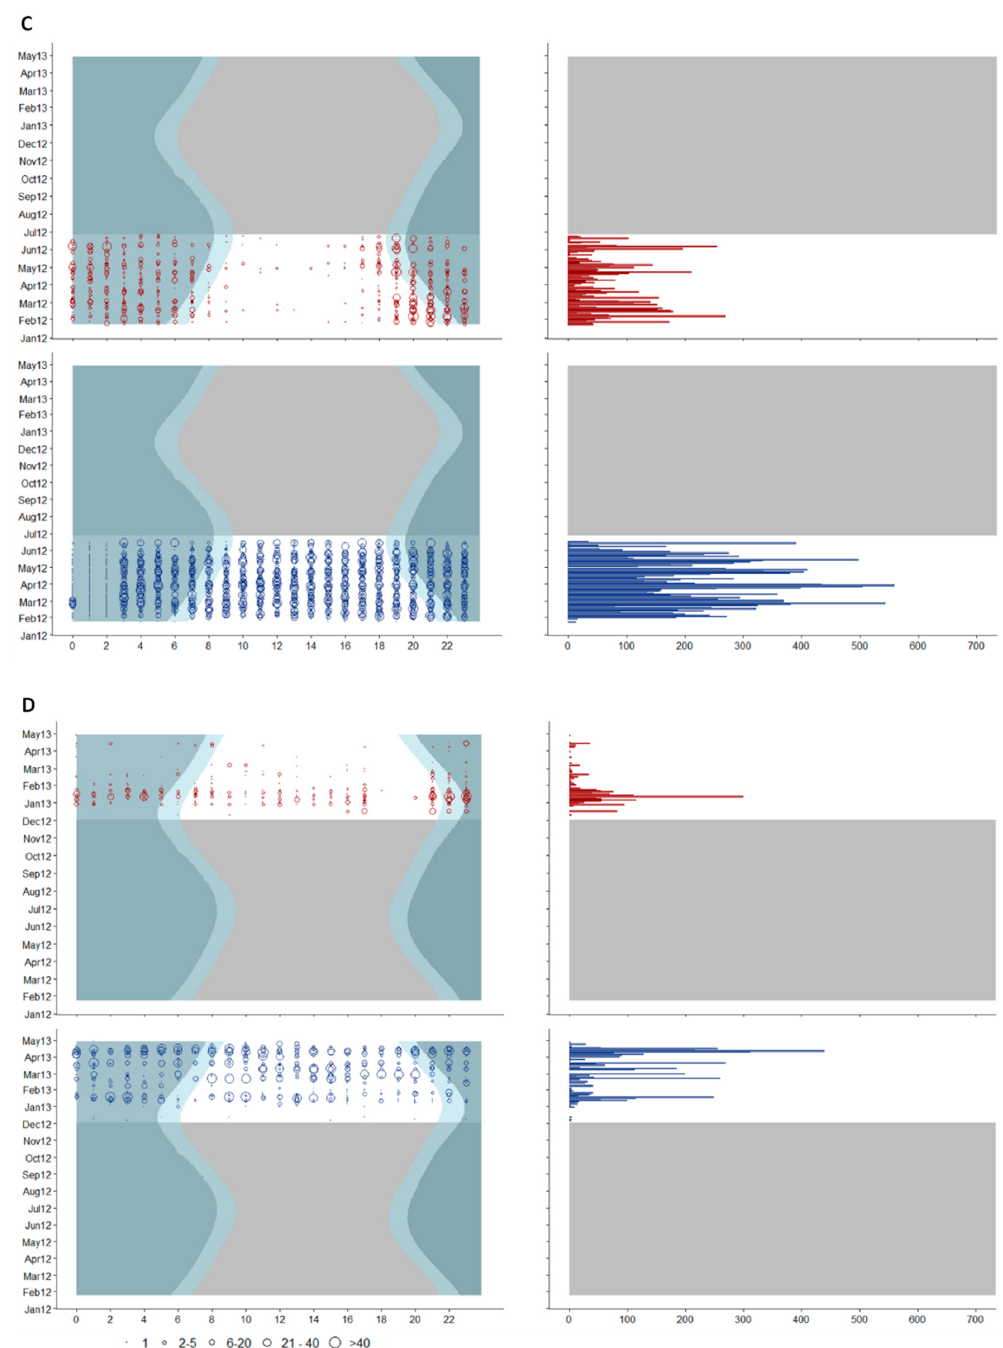
Figure 6. Diel distribution of blue whale D (red) and SEP (blue) call detections for each recording site: Guafo North ( A ), Melimoyu ( B ), Northwest Chiloe ( C ) and Tic Toc Bay ( D ). Left x-axis shows hour in Chilean Standard Time (CST); the right x-axis shows the daily total number of calls; y-axis shows the dates. Circles indicate the numbers of calls per hour, and the circle size is explained in the legend below the figure. Dark blue shading shows night periods, light blue shading shows twilight periods. Grey shading indicates periods of no recordings.